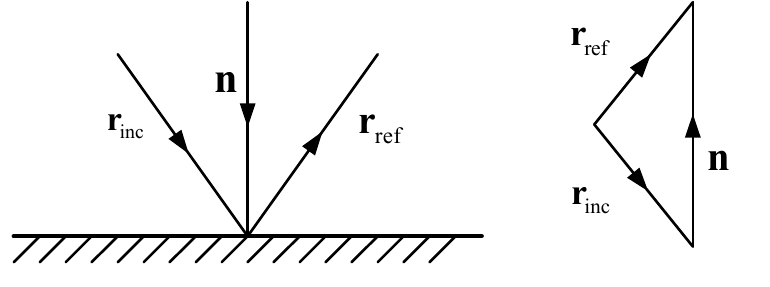
Figure 4. Illustration of the reflection law.